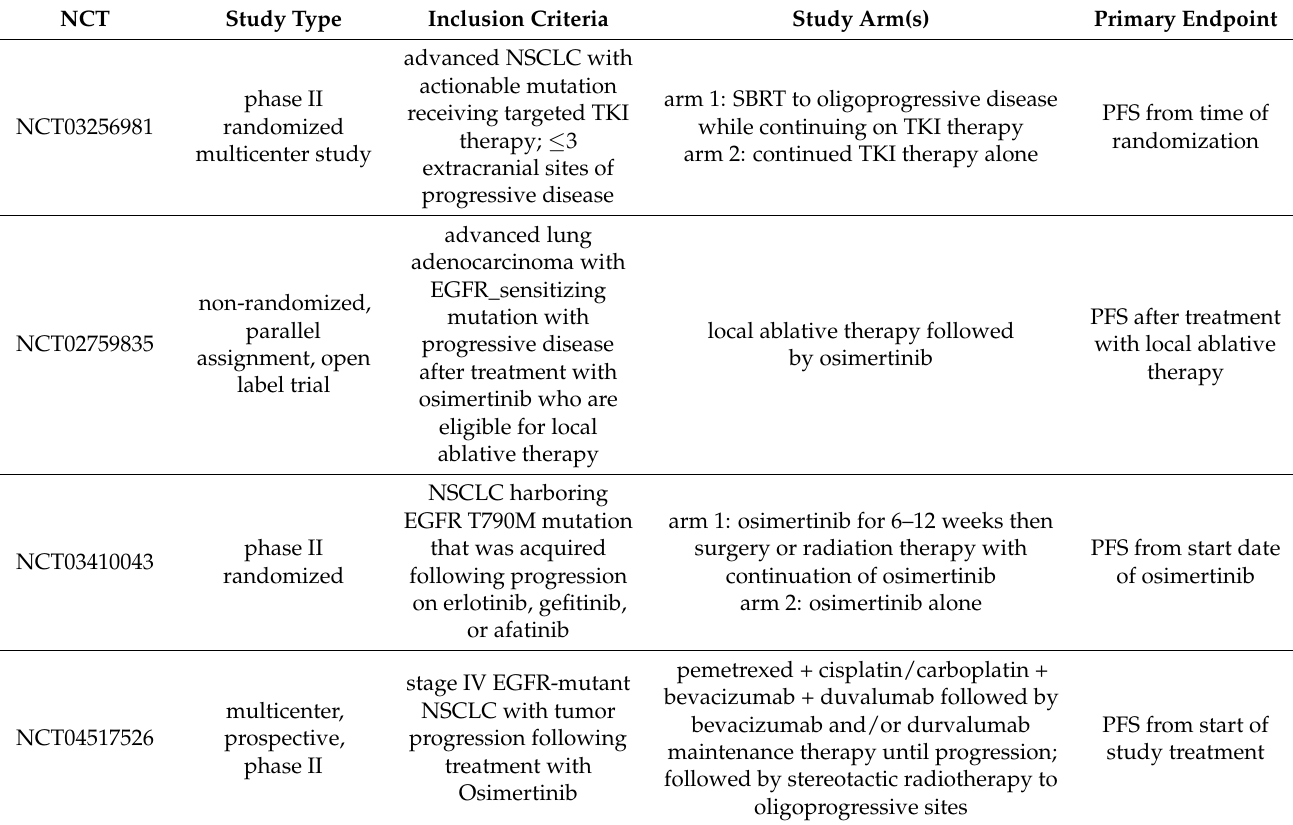
Table 2. Ongoing studies evaluating SBRT for Oligoprogressive EGFR-mutant